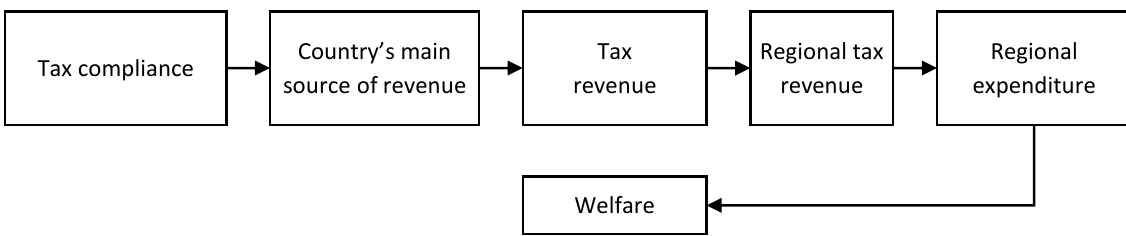
Figure 1. Relevance of tax compliance and